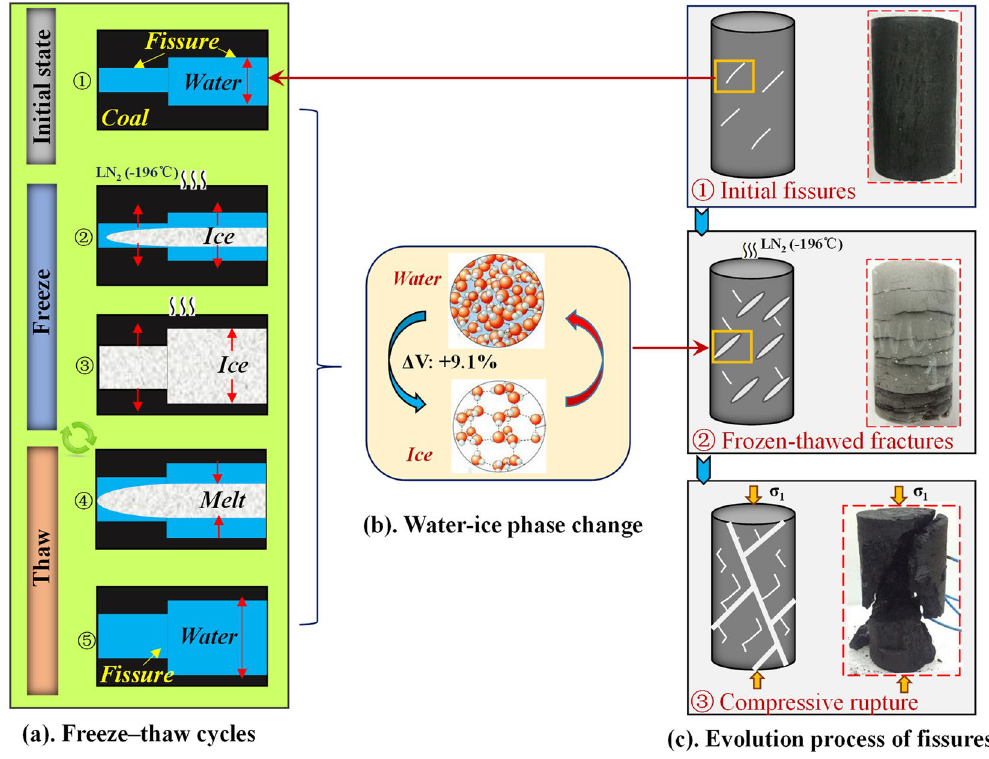
Figure 6. Modes of crack generation and extension in coal when the coal is treated with LN 2